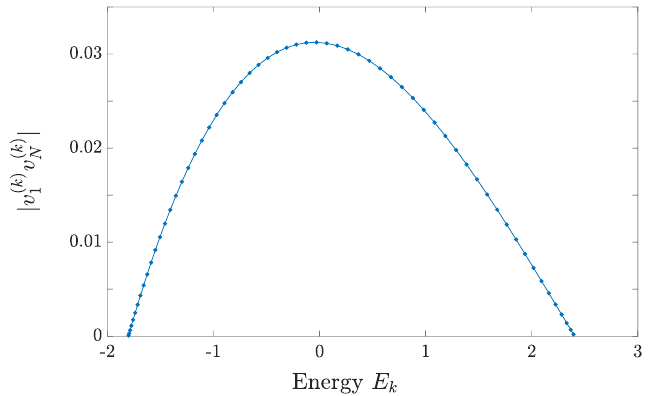
( k ) ( k ) | of the boundary amplitudes of k -th v N 1 (in units of J ), for an ordered chain k